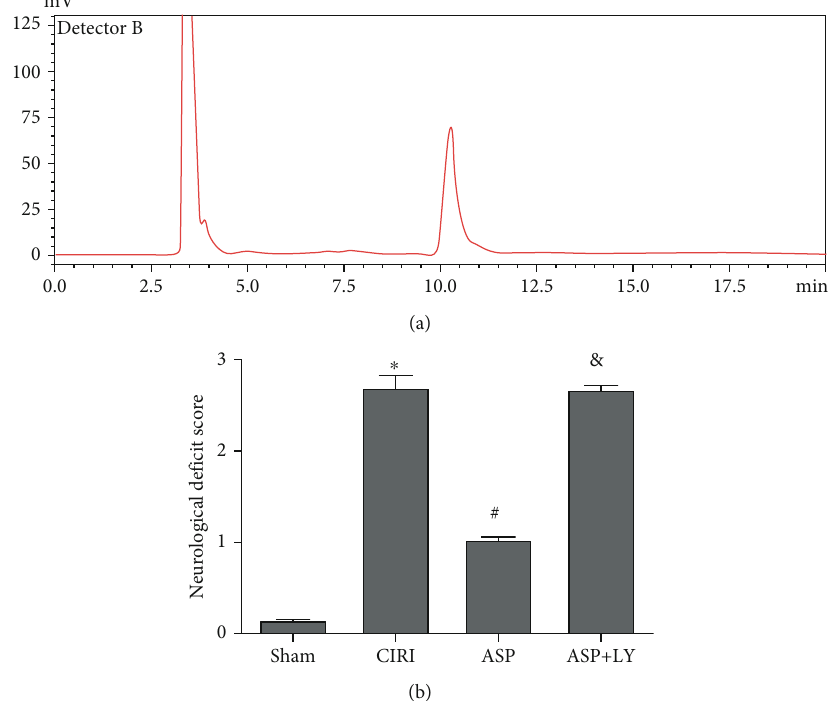
Figure 2: E ff ect of ASP treatment on rat neurological de fi cit after CIRI. (a) HPLC pro fi le of ASP. (b) ASP signi fi cantly reduces the neurological de fi cit score of CIRI rats. Note: compared with the sham group, ∗ P < 0 : 05 ; compared with the CIRI group, # P < 0 : 05 ; compared with the ASP group, & P < 0 : 05 . N = 10 per